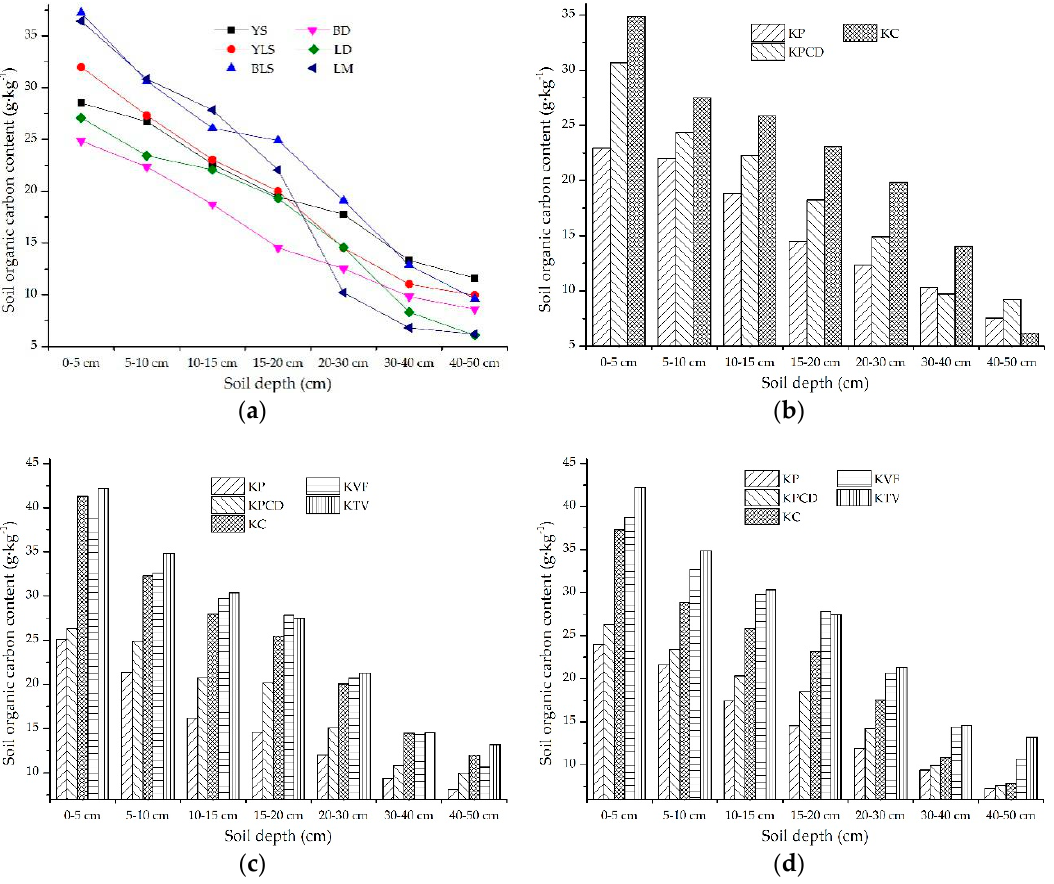
Figure 7. The spatial distribution characteristics of the soil organic carbon (SOC) content in different soil types: ( a ) shows the topsoil SOC content in different soil types; ( b ), ( c ) and ( d ) are the SOC contents in paddy soil, limestone soil and yellow soil, respectively.